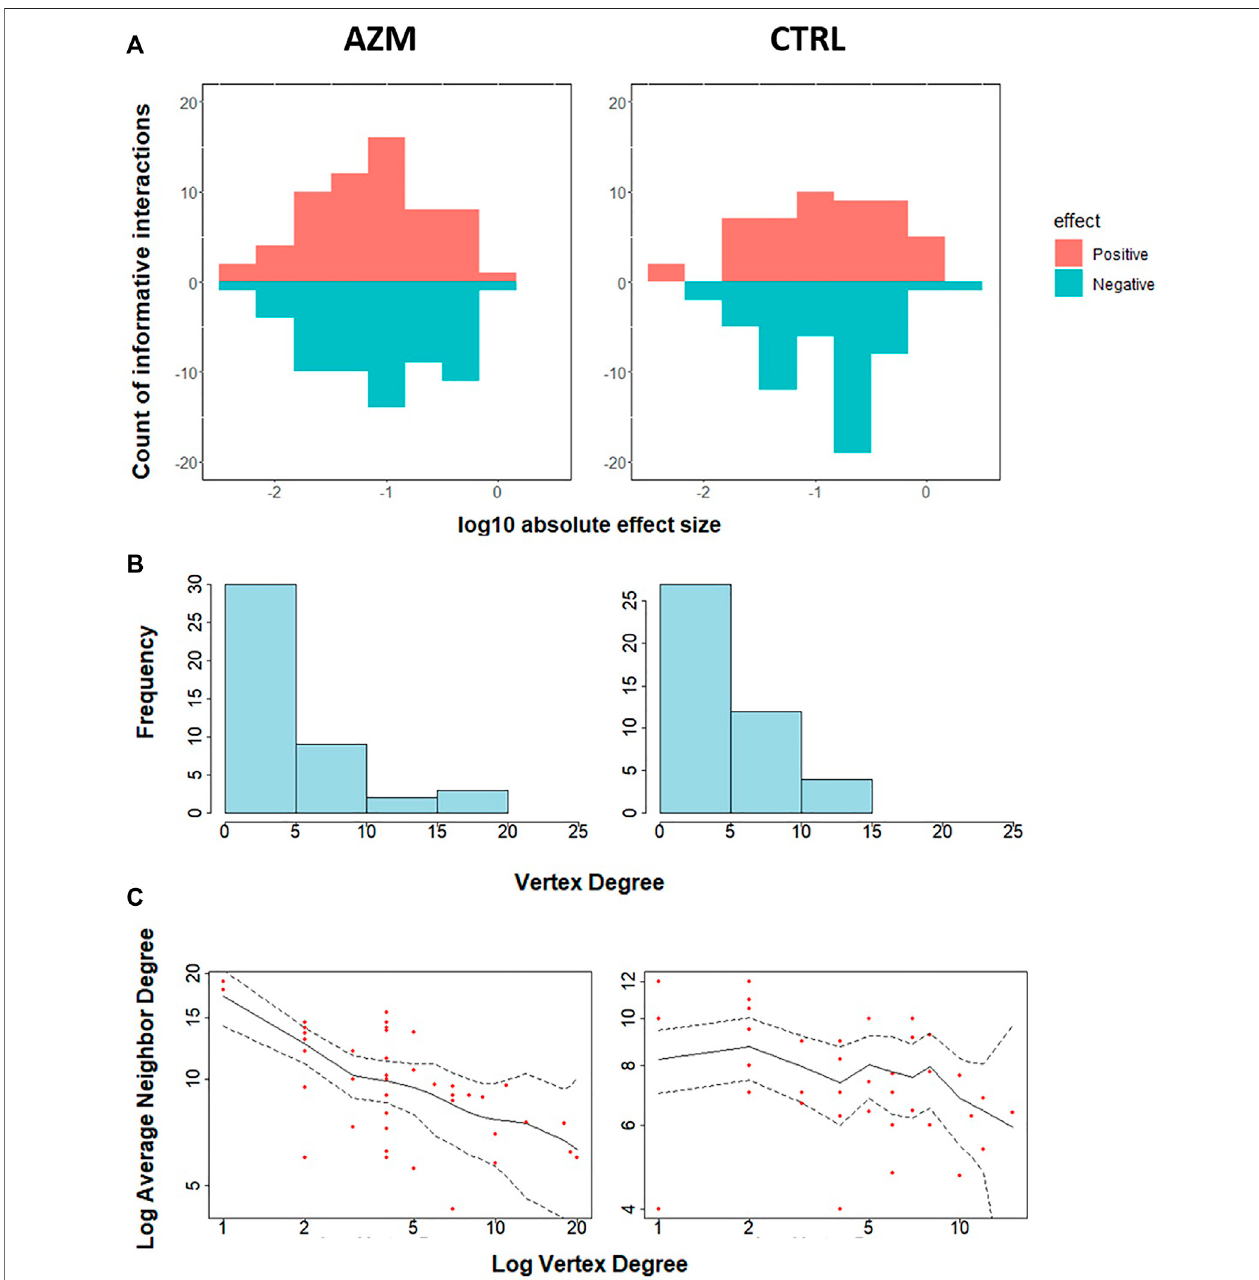
FIGURE 6 | Characteristics of estimated interactions. (A) The effect size of estimated informative interactions, wherein the x -axis represents the log 10 scaled absolute effect size, the y -axis represents the count of informative interactions, and the colors represent the positive or negative effects. (B) Histogram of vertex